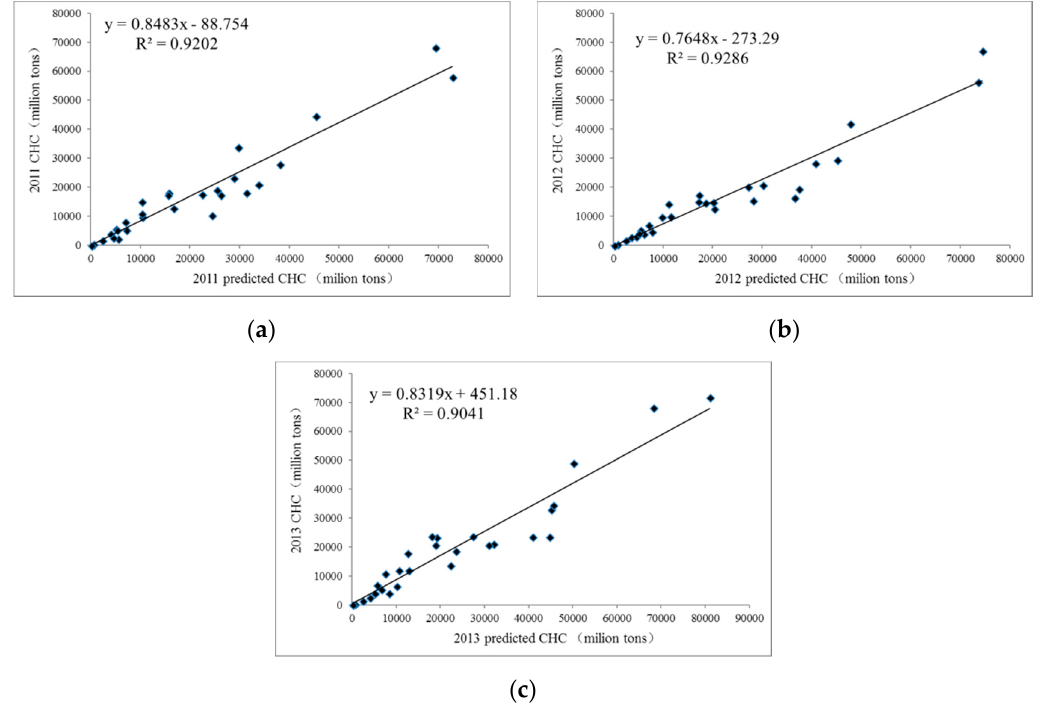
Figure 7. Fitting degree between real and predicted CHC of coastal ports for the year of 2011, 2012, and 2013: ( a ) Fitting degree between real and predicted CHC of coastal ports in 2011; ( b ) Fitting degree between real and predicted CHC of coastal ports in 2012; ( c ) Fitting degree between real and predicted CHC of coastal ports in 2013.